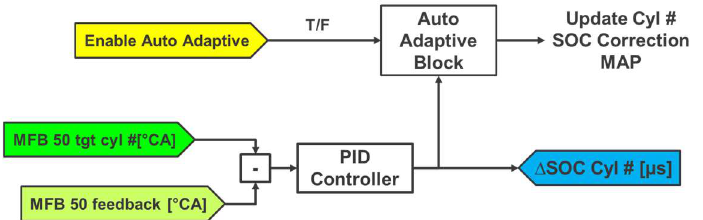
Figure 6. Schematic of the closed loop part of the controller defining the correction component of